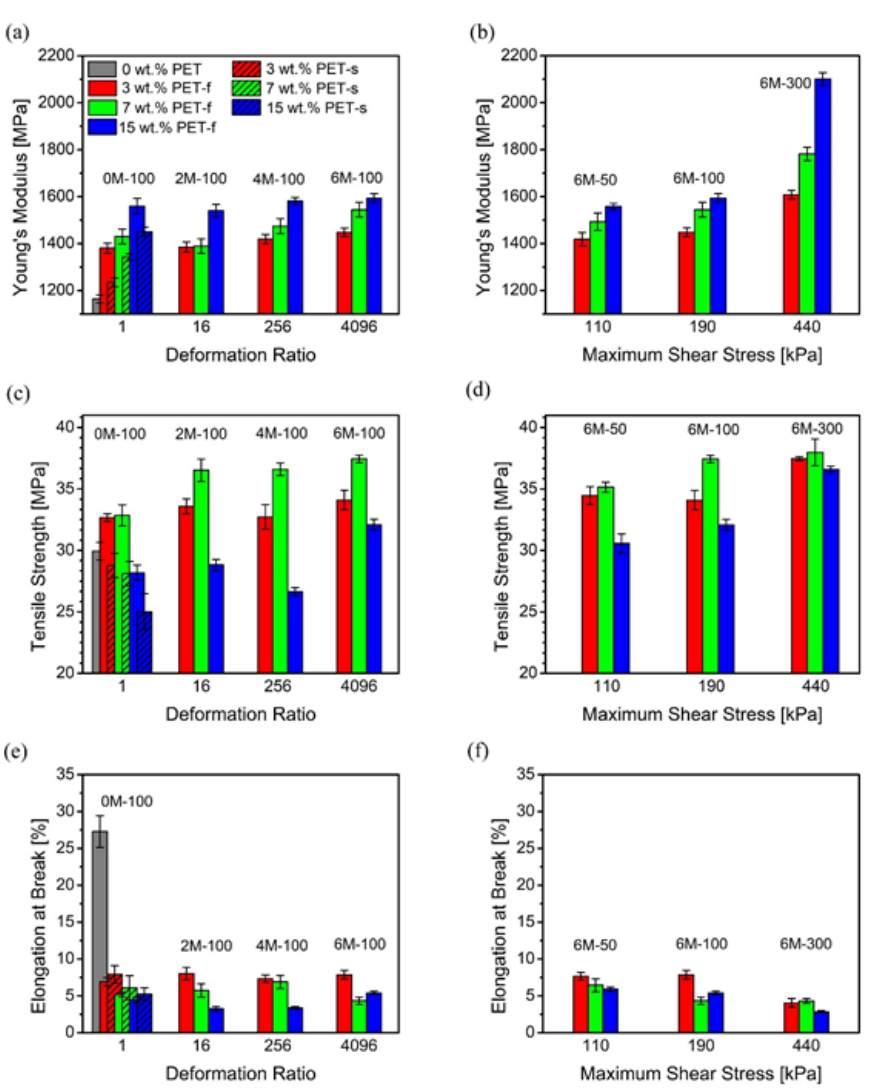
Figure 7. Tensile data of the MNL extruded PP / PET fibrillar blends. Charts ( a , c , e ) show the e ff ect of number of multipliers (i.e., deformation ratio). Charts ( b , d , f ) show the e ff ect of mass flow rate (i.e., shear stress). “f” and “s” denote fibrillar and spherical PET morphologies,